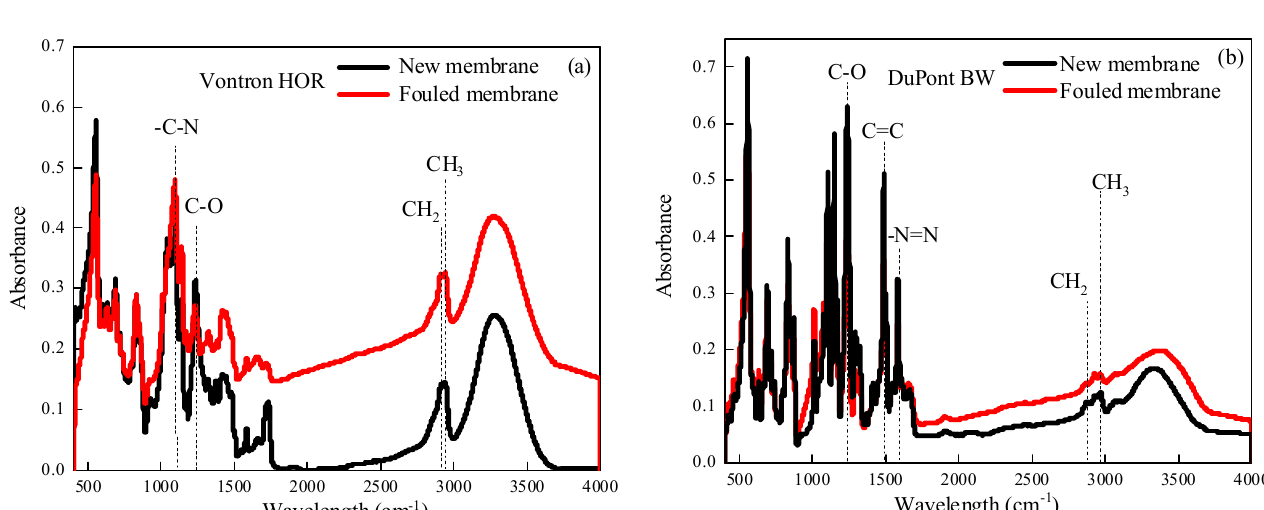
Table 5. Results of the orthogonal tests for candidate RO membranes.